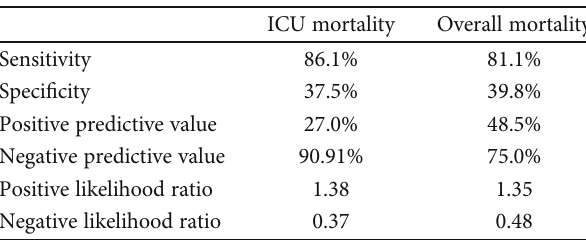
Table 6: MRproADM performance in predicting ICU or overall mortality using a cut-o ff of